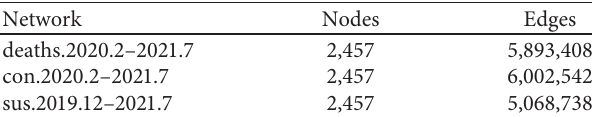
Table 2: Main characteristics for contagion networks. Network